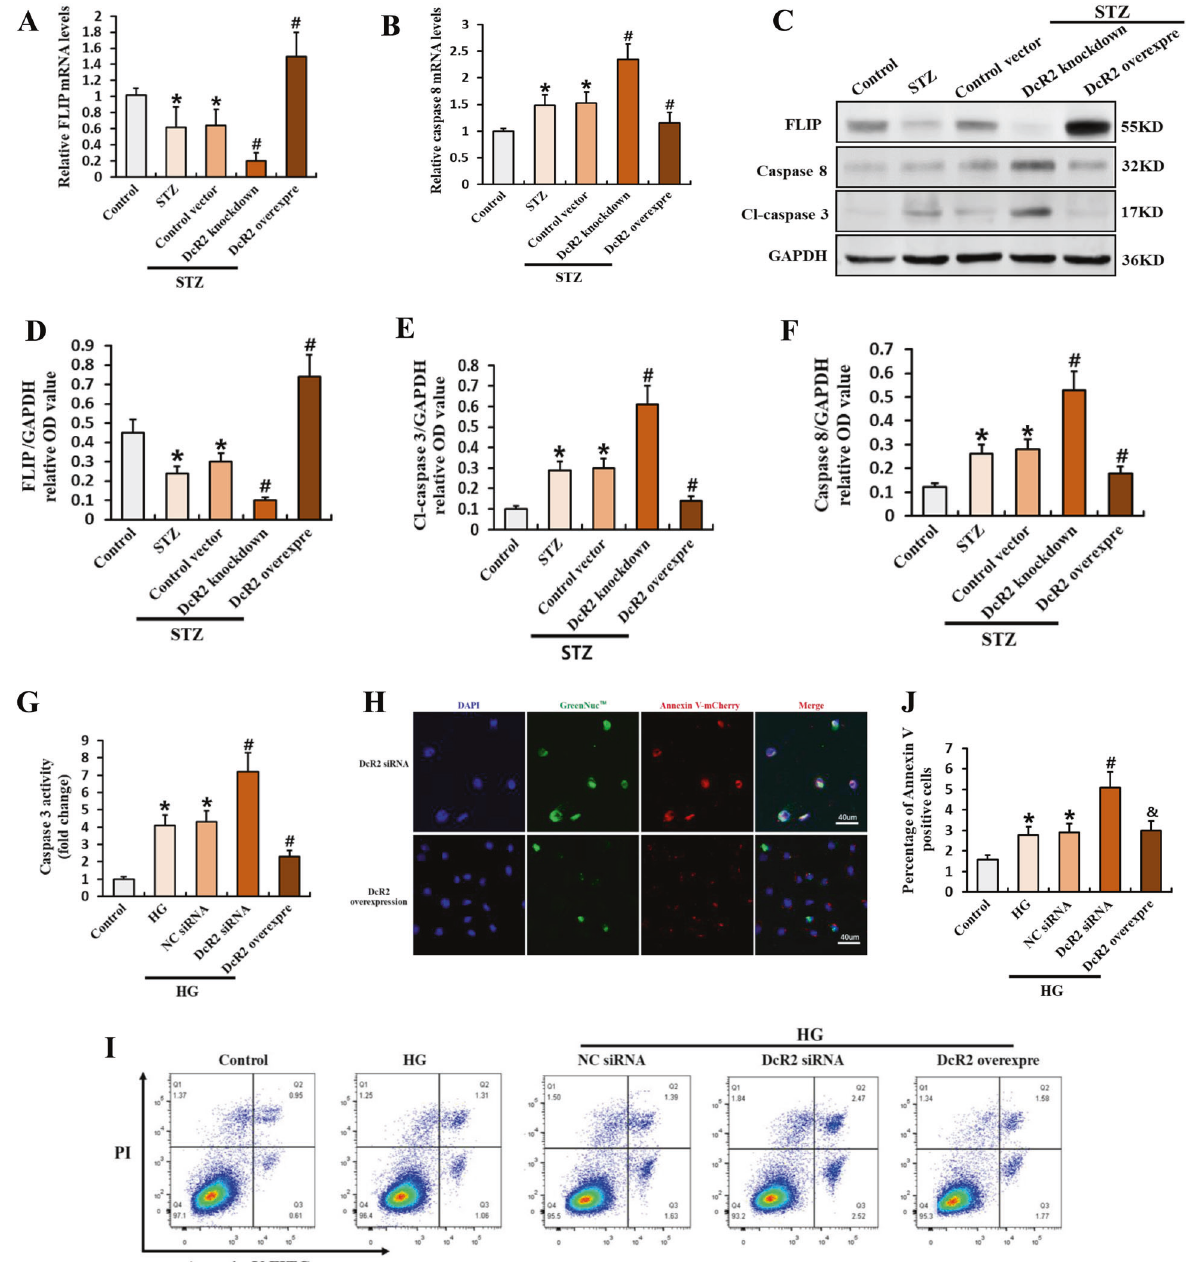
Fig. 4 DcR2 mediated the apoptosis-resistant phenotype of senescent RTECs in vivo and in vitro. A , B qRT-PCR results for FLIP and caspase 8 mRNA levels in each group ( n = 6). C . Western blotting results for the expression of FLIP, caspase 8, and cleaved caspase 3 in STZ-DN mice. D – F Quanti fi cation of FLIP, caspase 8, and cleaved caspase 3 expression in C, normalized to GAPDH ( n = 6). G Caspase 3 activity in HG-induced primary RTECs ( n = 4). H Representative micrographs showing the expression of caspase 3 (green) and Annexin V (red) in vitro. Scale bar, 40 μ m. I – J Apoptosis rate as detected via fl ow cytometry and the percentage of Annexin V-positive RTECs ( n = 6 for each group). Data are expressed as the mean ± SD for each group. * P < 0.05 versus control; # P < 0.05 versus STZ/ HG; & P < 0.05 versus HG + DcR2siRNA. Cell Death and Disease (2022)